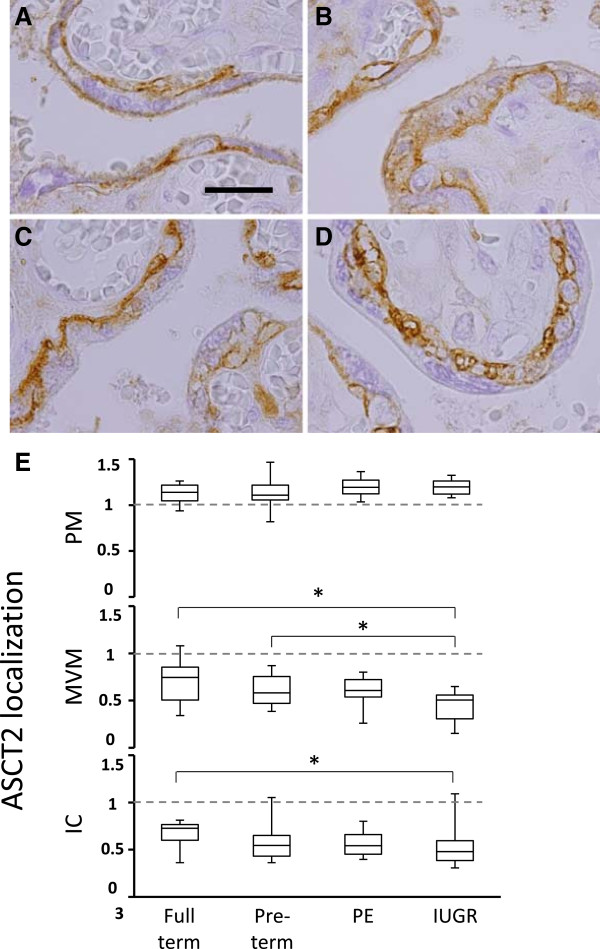
ASCT2 protein localization within the syncytiotrophoblast. ASCT2 protein was detected by immunohistochemistry in the placenta of A, full-term control, B, pre-term control, C, preeclampsia and D, intrauterine growth restriction-associated pregnancies. E, ASCT2 protein expression levels were estimated in the syncytiotrophoblast, including subcellular localization at the plasma membrane (PM), microvillus membrane (MVM), and the intracellular compartment (IC) (* P < 0.05, size bar = 40 mM).